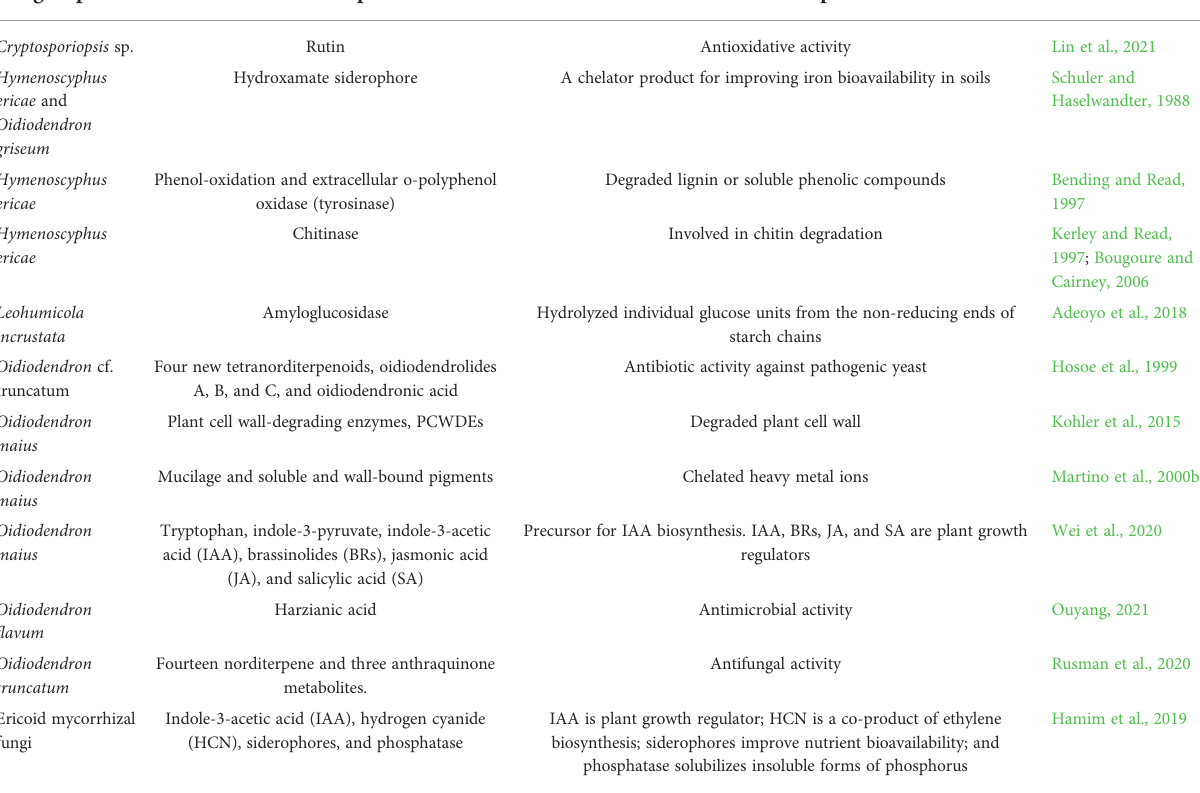
TABLE 2 Bioactive compounds released by ericoid mycorrhizal